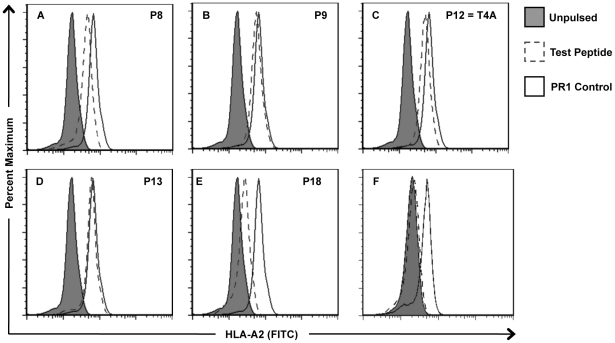
Peptide binding to HLA-A2.All synthesized peptides from Table 2- were tested for binding to HLAA2 using a T2 cell binding assay. Unpulsed T2 cells are shown as shaded traces. Test peptide-pulsed T2 cells are shown as traces with dashed lines, and PR1-pulsed T2 cells are shown as solid black lines. The PR1 peptide was used as a positive control because it binds HLA-A2 with high affinity. Five of 17 peptides bound to HLA-A2 with an increase in geometric mean fluorescence of >1.5 fold compared to the non-pulsed control (2A–2E). A representative non-binding peptide is shown (2F).